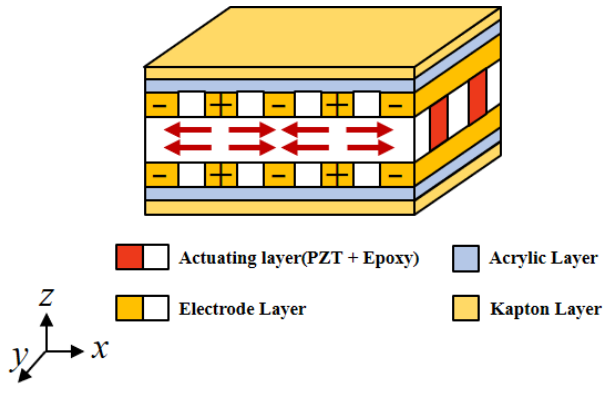
Figure 1. Internal structure of the MFC.